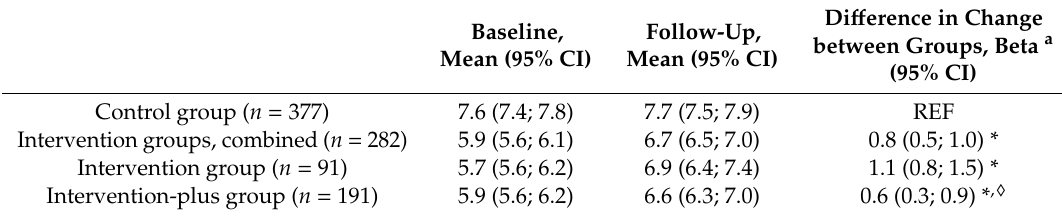
Table 3. Baseline, follow-up, and di ff erence in change in between groups in Shuttle Run Test scores ¥ , by experimental